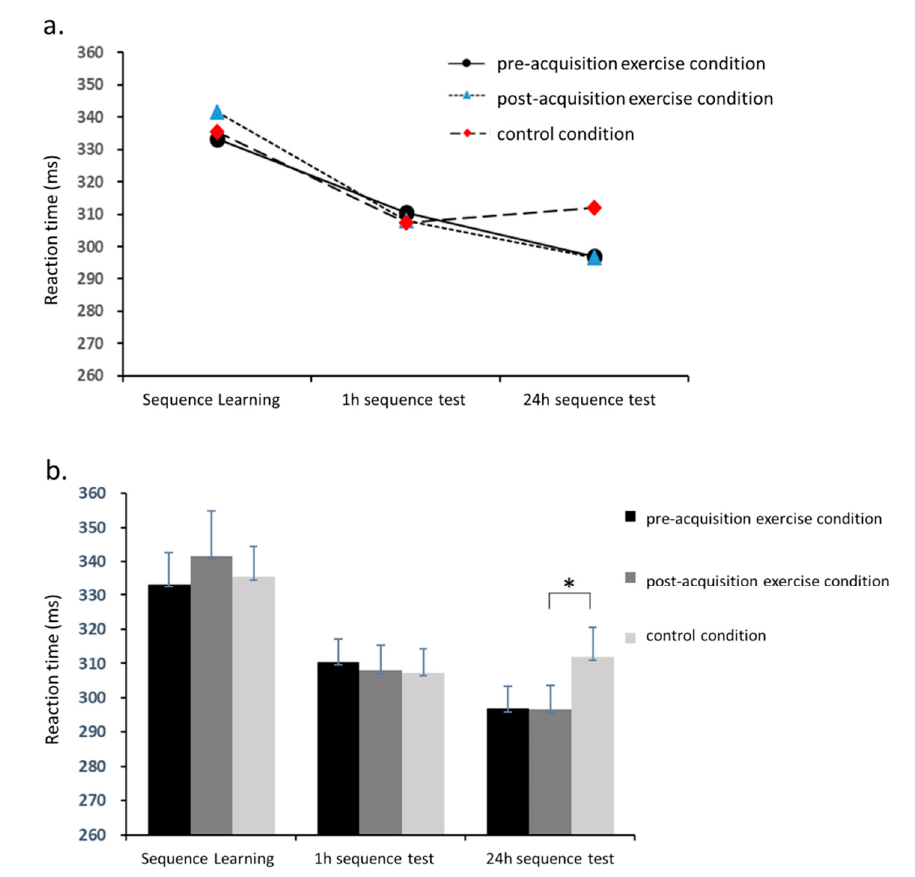
Figure 6. Comparison of reaction times in the serial reaction time task in the PM experiment. ( a ) Comparisons over time. ( b ) Comparisons between conditions. * p < 0.05.